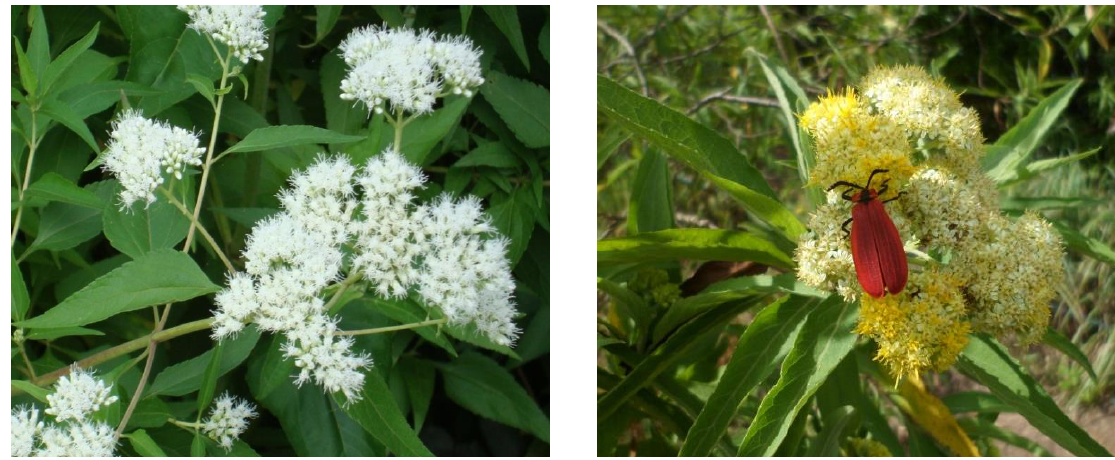
Figure 1: The inflorescences of Austroeupatorium inulifolium (Left) and Psiadia ceylanica (Right). Photo Credit: Inoka